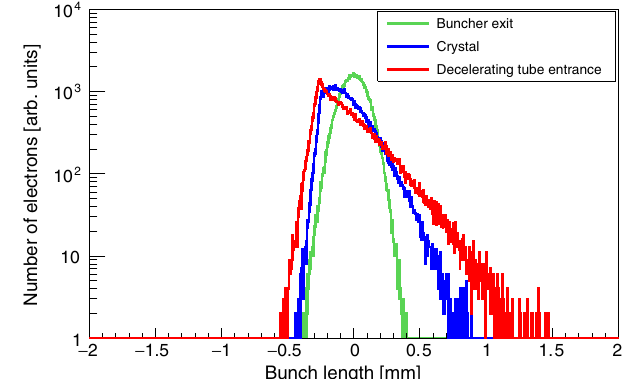
ffiffiffi p β FIG. 16. Bunch length at the exit of the buncher (green), the collision point (blue), and the decelerating structure